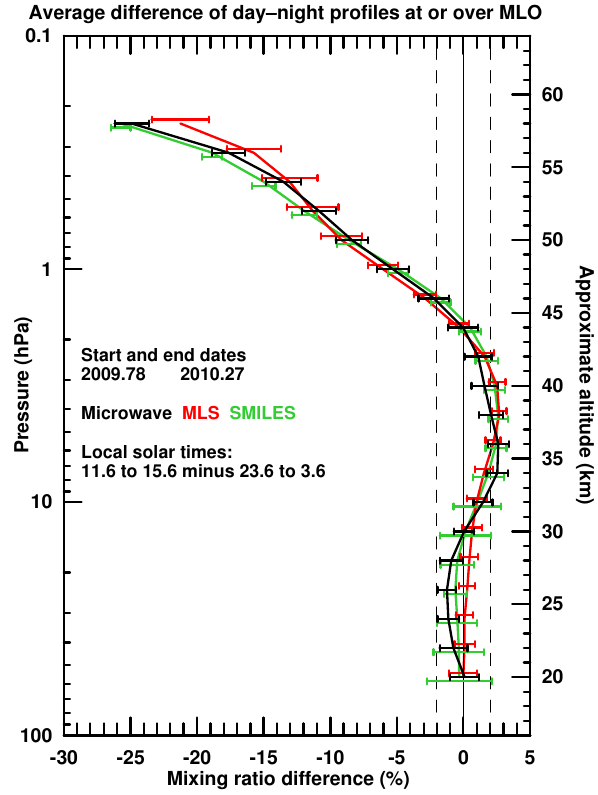
Figure 5. Afternoon–night differences derived from SMILES (green), Aura-MLS (red), and MWR selected data (black) at Mauna Loa. The SMILES and Aura-MLS measurements have been con- volved with the MWR averaging kernels. All measurements have been averaged over the indicated SMILES observing period. The afternoon SMILES and MWR measurement pairs were averaged over the periods 11:36 to 15:36 and the nighttime over 23:36 to 03:36LST. The time ranges for MLS are narrower, 13:00 to 13:48 and 01:30 to 02:24LST because Aura is in a sun-synchronous orbit. Individual measurements were averaged over the period 12 October 2009 to 9 April 2010 and combined as described in Sect. 2.1 to make these profiles. Error bars are calculated and displayed as described in the caption for Fig.